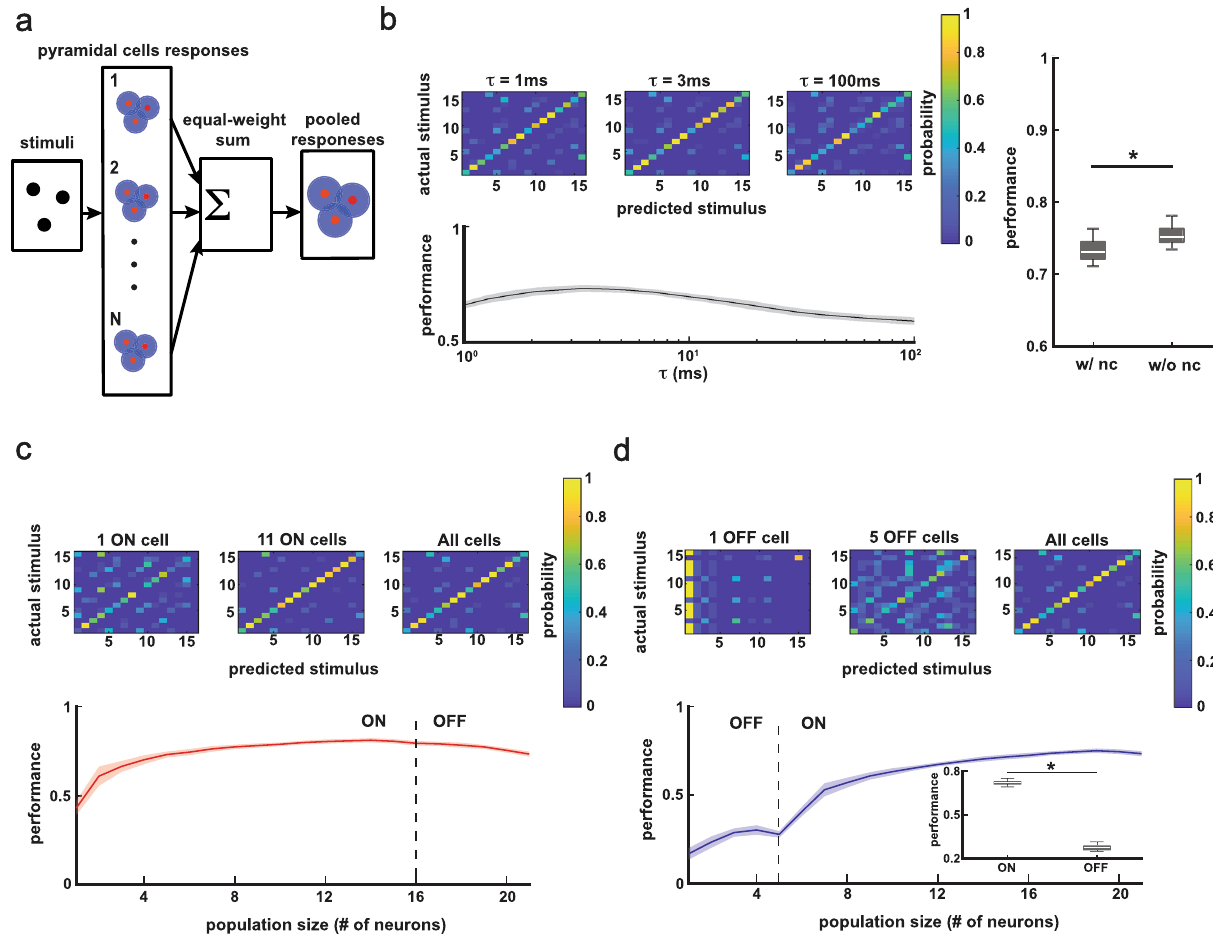
Figure 4. Discrimination performances of population activities when using an equal-weight sum to combine neural activities. ( a ) Schematics showing how the responses of ELL pyramidal cells were summed with equal weights. ( b ) Left top: confusion matrices where each entry is the probability of a stimulus i predicted as stimulus j (prediction based on distance between neural responses quantified by van Rossum metric with timescale τ, see “Materials and methods” for details) for a population of 21 neurons consisting of 16 ON cells and 5 OFF cells with τ = 1, 3 and 100 ms. Left bottom: discrimination performance as a function of τ. The shaded areas represent standard deviation when using 30 different sub-trials (60% of all trials), and same for ( c ) and ( d ). The range of τ values for which performance was higher than 90% of the maximum is 6 ms. Right: boxplots showing that equal-weight sum of neural activities without noise correlations (right) had better performance than that with noise correlations (left; one-way ANOVA, p = 1.3 × 10 –4 ). ( c ) The effect of population size on discrimination performance. ON cells were first considered before OFF cells. Top: confusion matrices for populations of 1 ON cell, 11 ON cells, and all cells (16 ON cells and 5 OFF cells) with τ = 3 ms. Bottom: discrimination performance as a function of population size. ( d ) Same as ( c ) but OFF cells were first considered before ON cells. Top: confusion matrices for populations of 1 OFF cell, 5 OFF cells, and all cells (16 ON cells and 5 OFF cells) with τ = 3 ms. Bottom: discrimination performance as a function of population size. Inset: boxplot showing that 5 ON cells had better performance than 5 OFF cells (one-way ANOVA, p = 1.0 × 10 –66